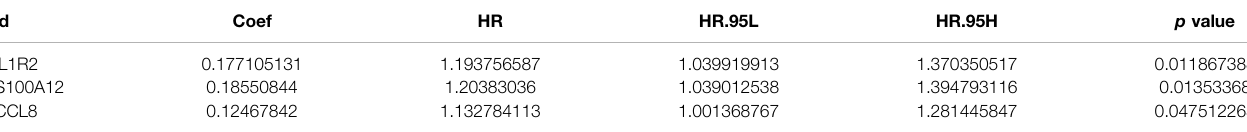
TABLE 1 | Results of multivariate Cox regression